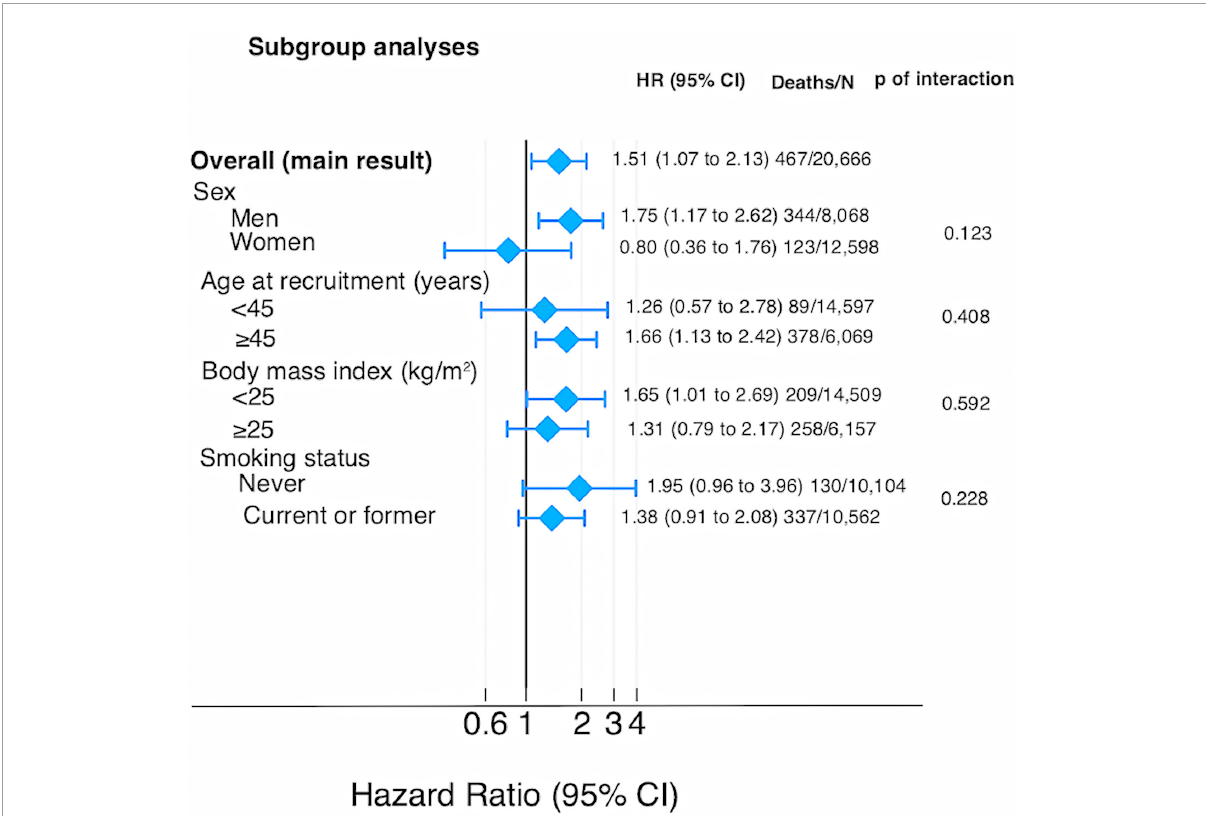
FIGURE3 Sub-group analyses for the association between Chilean warning label score and all-cause mortality (multivariable-adjusted HR and 95% CI for the highest vs. lowest